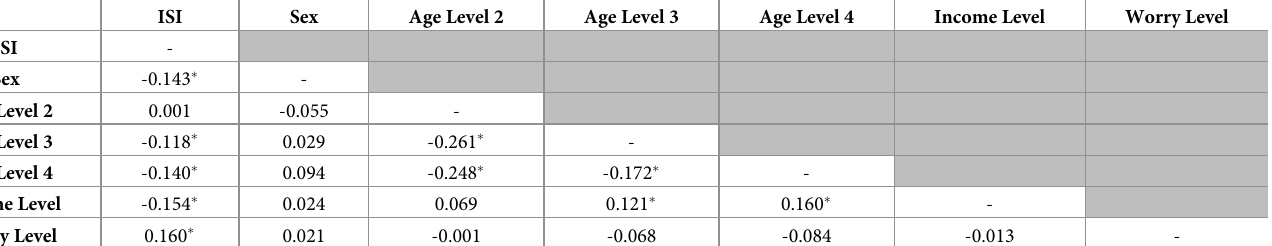
Multiple regressions were run to predict insomnia and daytime sleepiness from sex, age, income level, and the worry score as independent categorical (binary/dummy) variables. There were significant negative associations of insomnia with sex, age levels 3 and 4, and income level, and a significant positive association between insomnia and worry level (Table 3). Insomnia revealed a significant regression equation (F (6,384) = 6.53, p < . 001 , R 2 = .09) indicating that sex, age, income level, and worry scores significantly predicted insomnia.